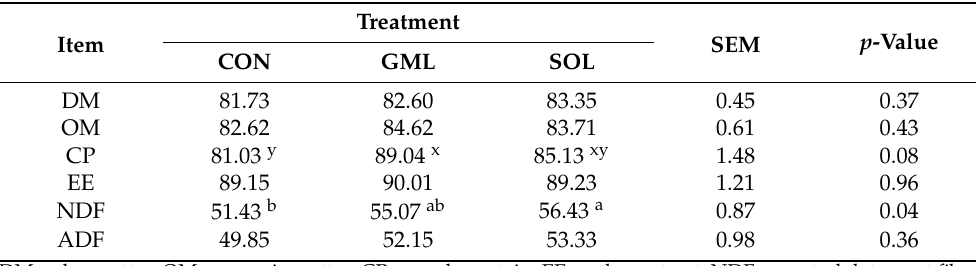
Table 3. Effects of monoglyceride laurate and Solider on the apparent digestibility of nutrient components in weaned lambs (%).